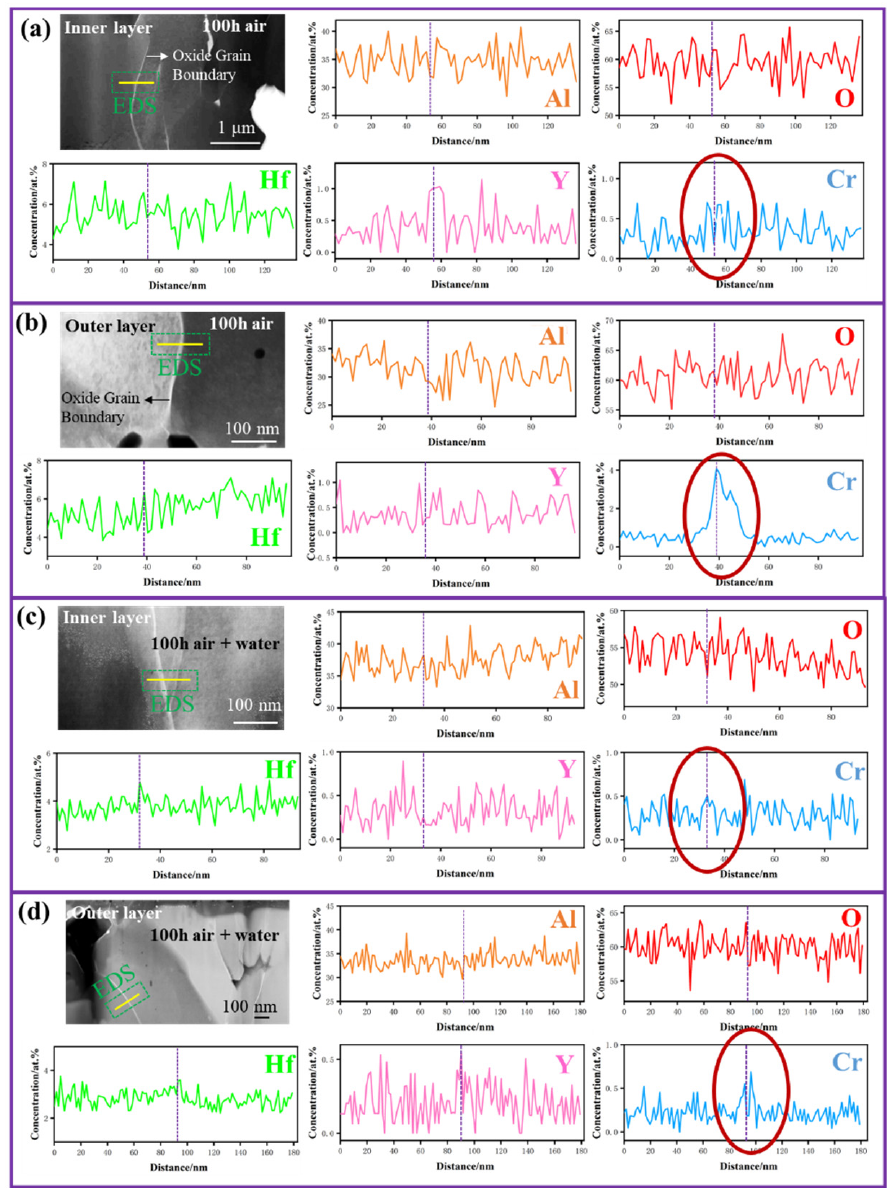
Figure 9. The morphology and EDS of the NiCrAlYHf alloy oxide scale after 100 h at 1100 °C: air, inner layer ( a ); air, outer layer ( b ); air–water vapor, inner layer ( c ); air–water vapor, outer layer ( d ).